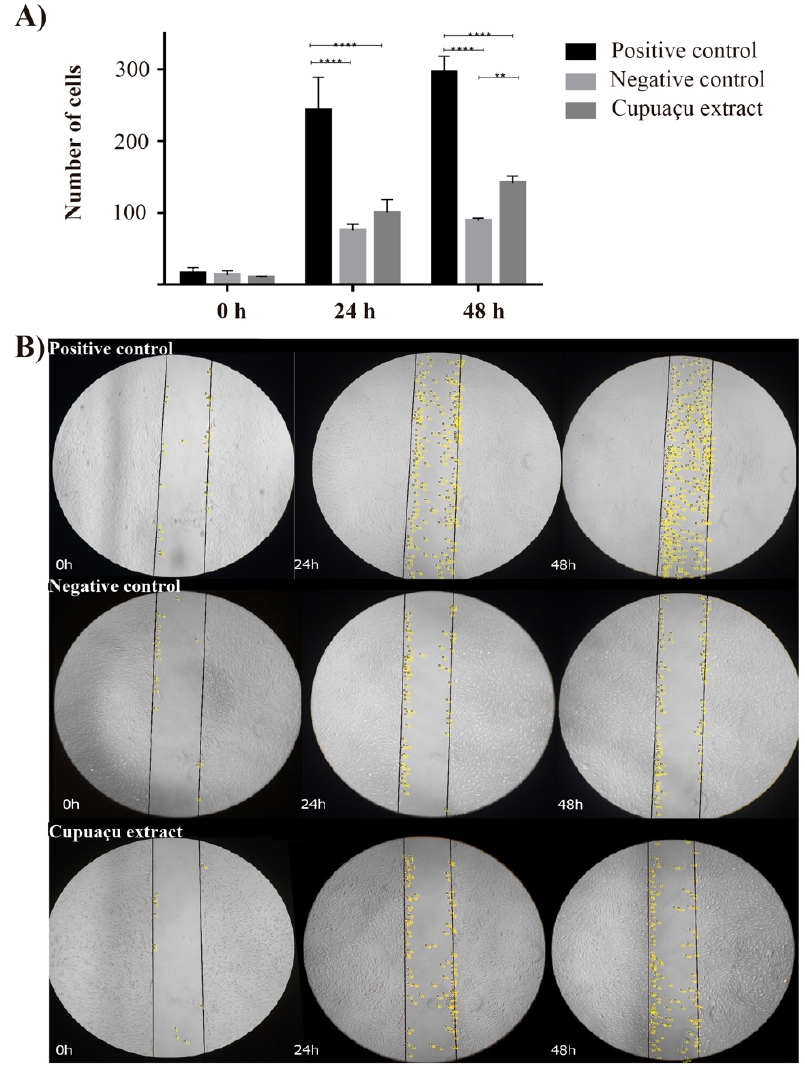
Figure 2. Migratory behavior of fibroblasts treated with 100 µ g/mL Cupuaçu seed extract. ( A ) cellular migration normalized to the positive controls in each time point. ( B ) Wound closure immediately after scratch, 24 and 48h later. Positive controls received FBS supplementation and negative controls consisted of cells maintained without FBS supplementation. Statistical differences have been verified by two-way ANOVA test and Tukey post hoc test. ** p < 0.01; **** p < 0.0001. Yellow dots represent a migrating cell at that specific time.